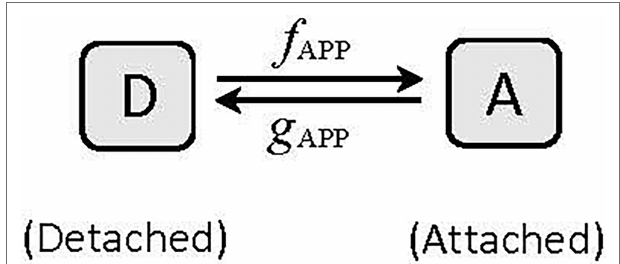
FIGURE 6 | A two-state model of cyclic interaction of myosin crossbridges with actin filaments. A, attached state, D, detached state. f APP and g APP denote the apparent forward and reverse rate constants,